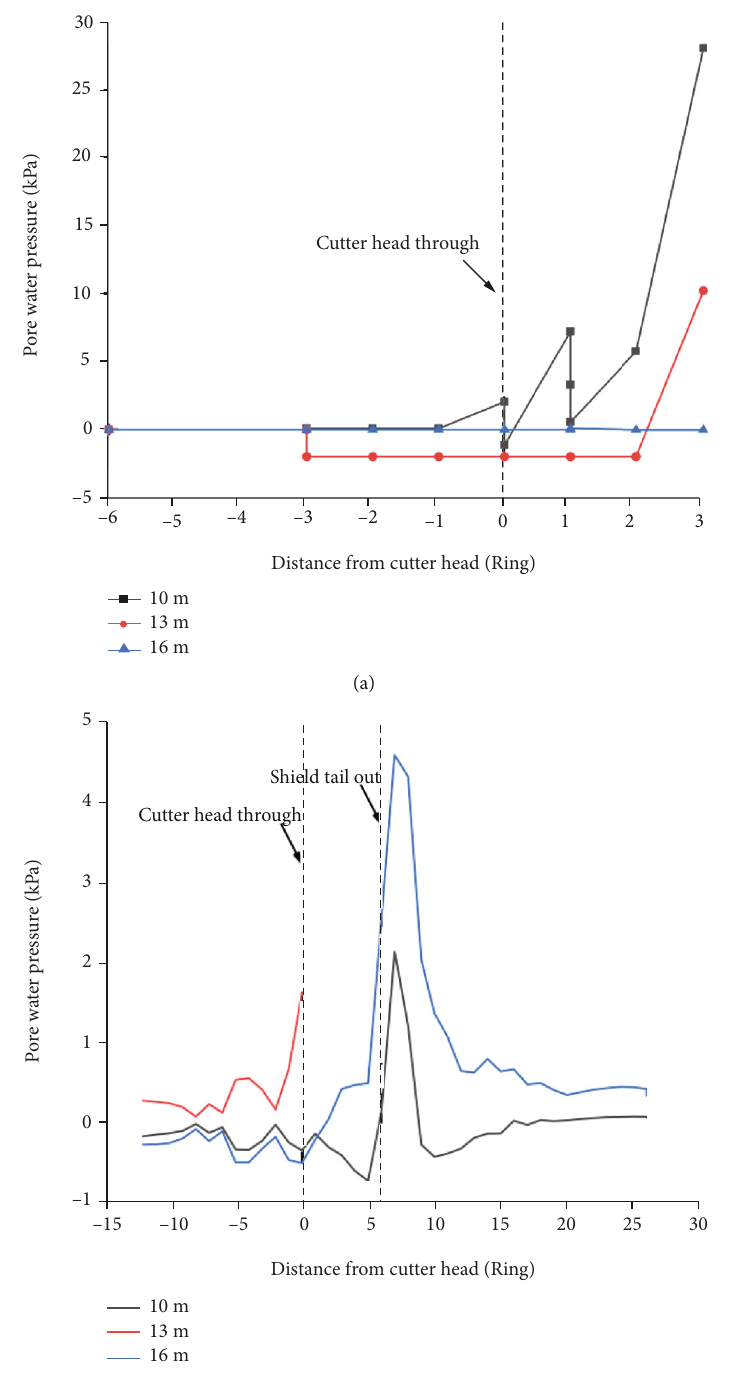
Figure 12: Excess pore water pressure time history curve at di ff erent buried depths of tunnel centerline: (a) measured values and (b) calculation